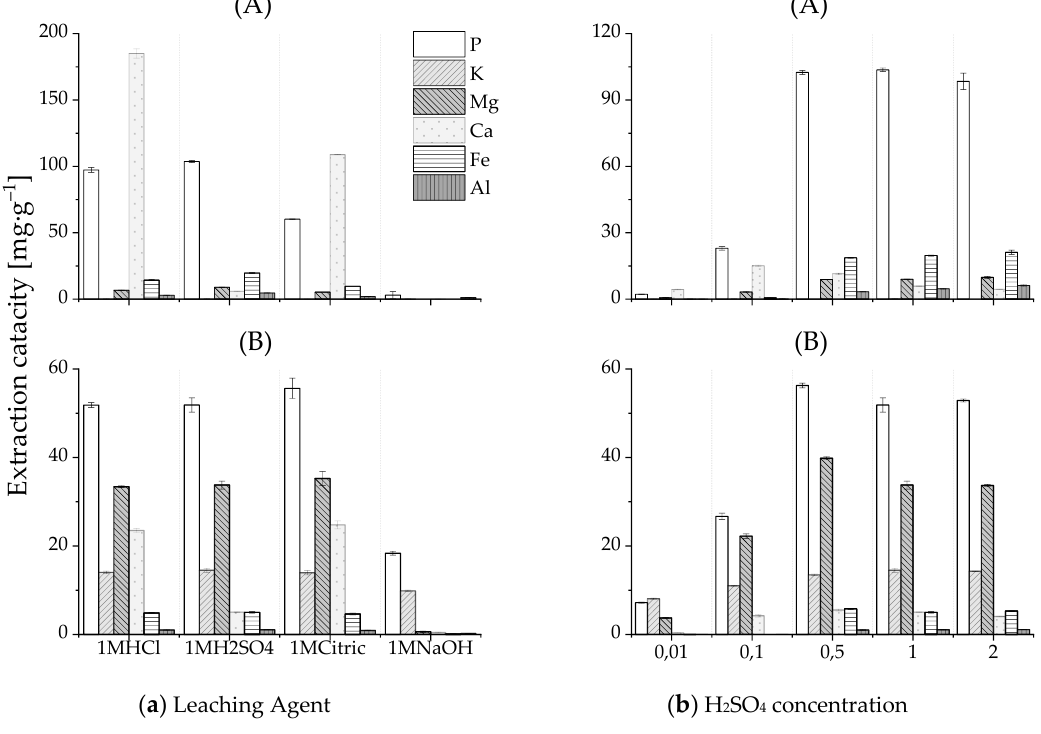
Figure 4. Effect of the leaching agent ( a ) and H 2 SO 4 concentration ( b ) on the extraction capacity of elements P, K, Mg, Ca, Fe, and Al for the HTL solid phase from PSS (A) and SPR (B).